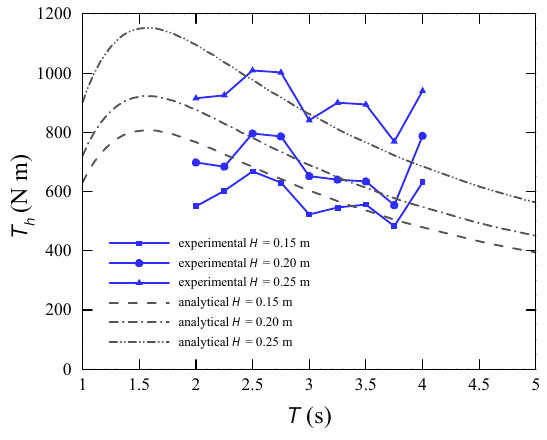
Figure 8. Comparison between experimental and analytical variations of the amplitude of hydrodynamic torque with a wave period.